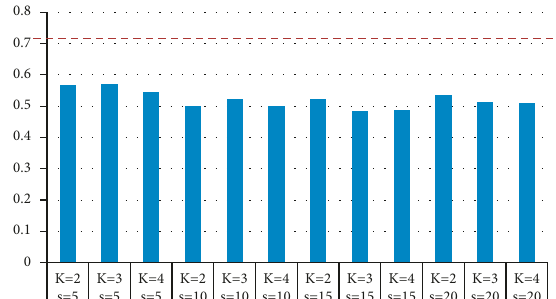
Figure 3: Specificity of CBCD on GS with a threshold 0.01.